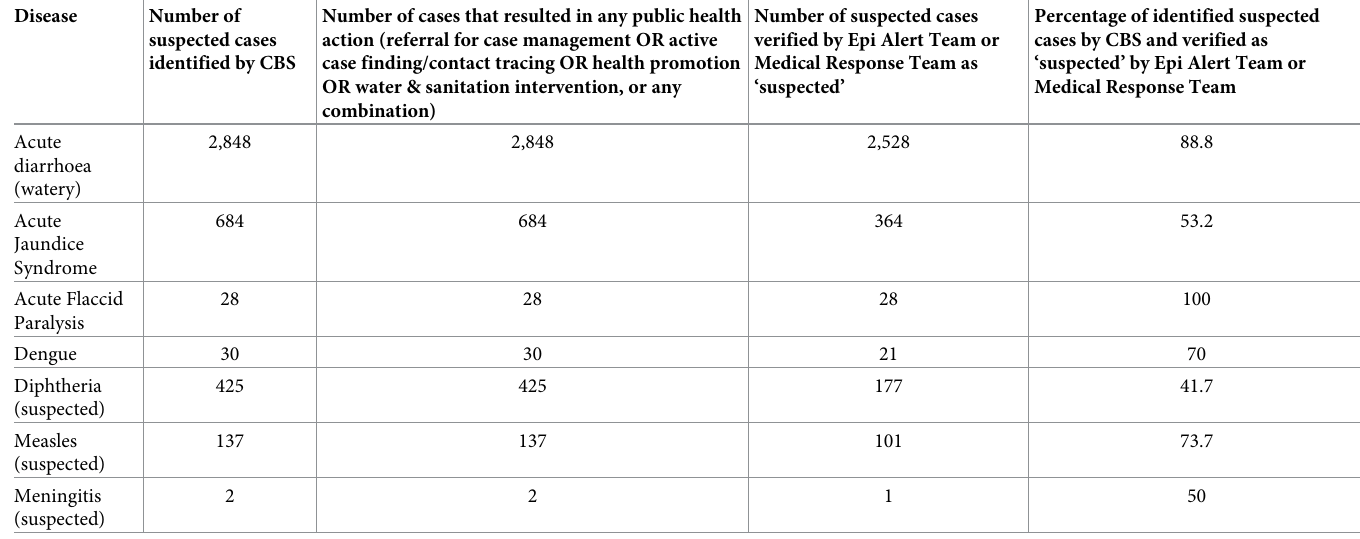
Table 5. Positive predictive value of a notified suspected case to meet the case definition in MSF’s CBS in Cox’s Bazar, Bangladesh, week 20–44, 2019. Disease Number of suspected